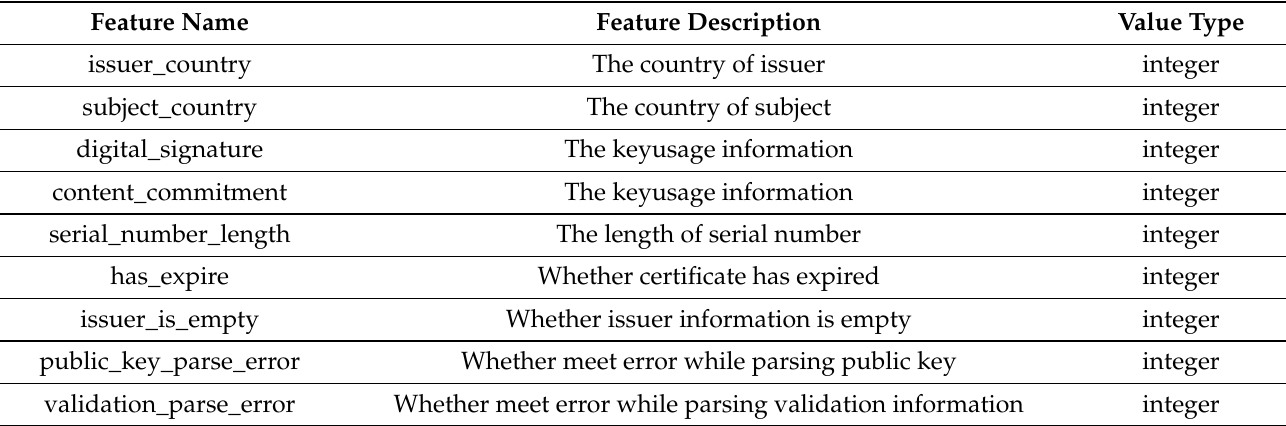
Table 4. Sample features from basic analysis.